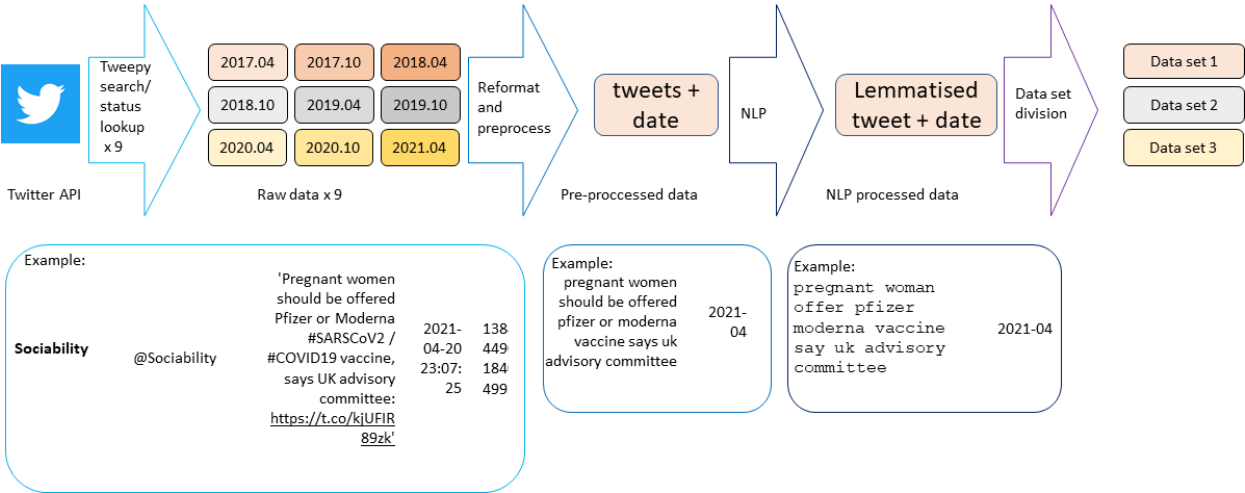
Figure 2. The research process from collecting Twitter data through to analysis via the two different ML models, with examples of how an individual tweet appears at key